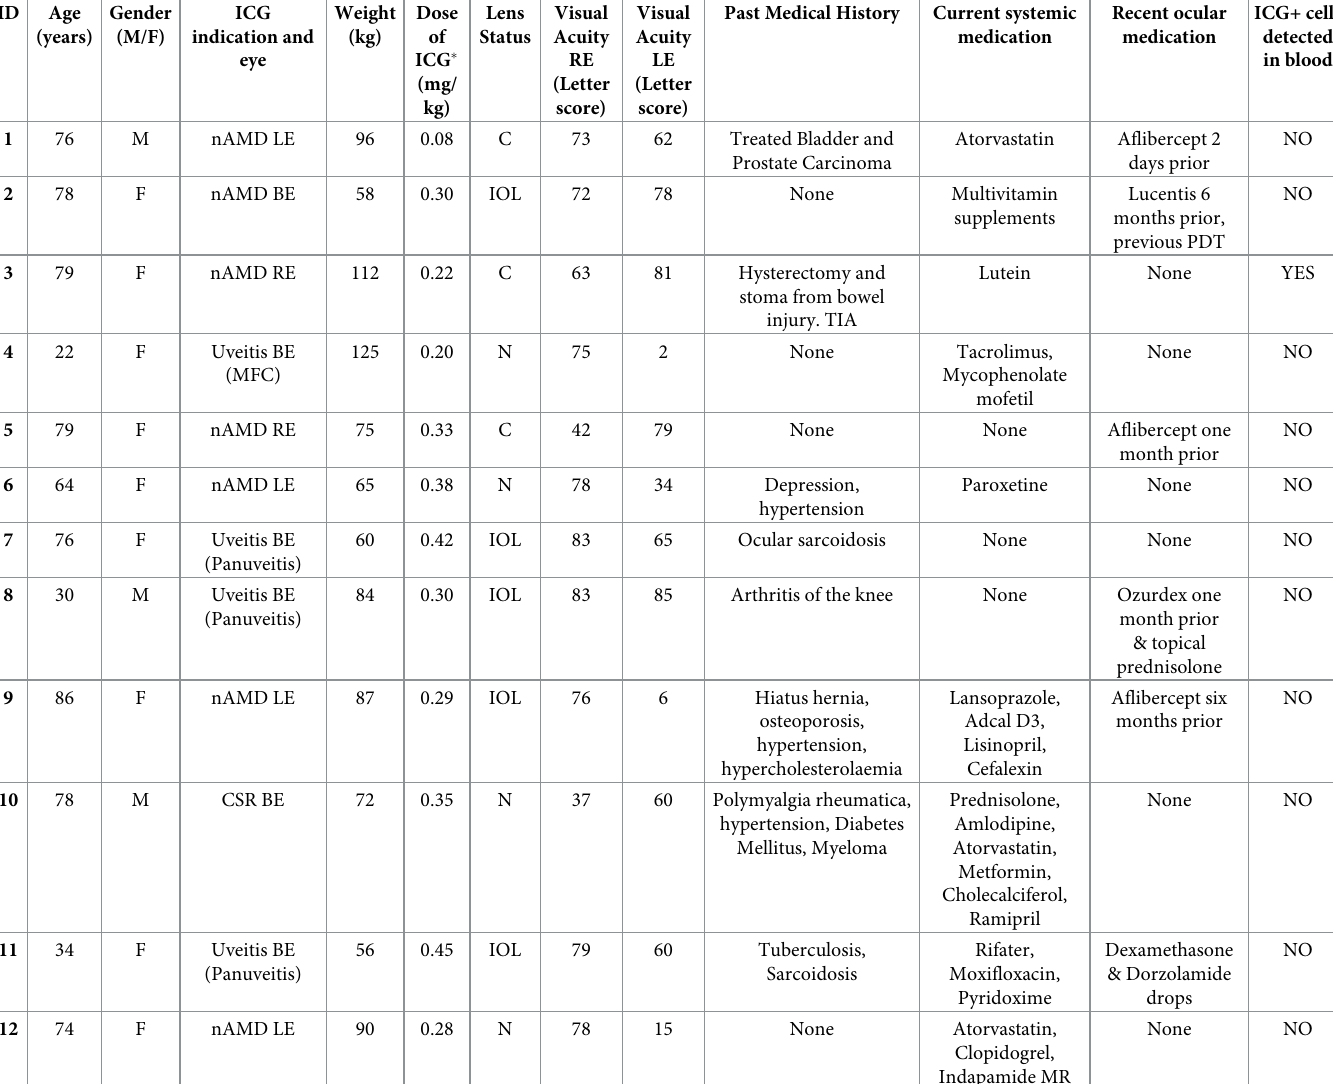
Table 1. Demographics of participants enrolled in the study with a clinical indication for routine ICG